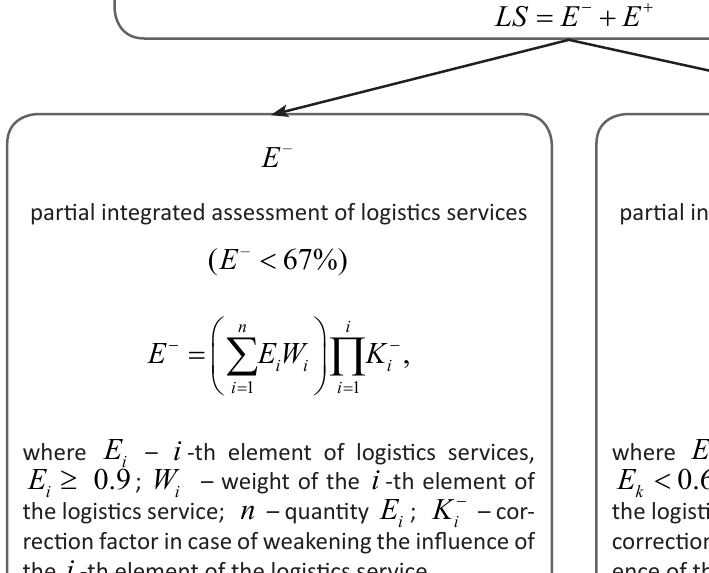
Integrated index of logistics services ( LS